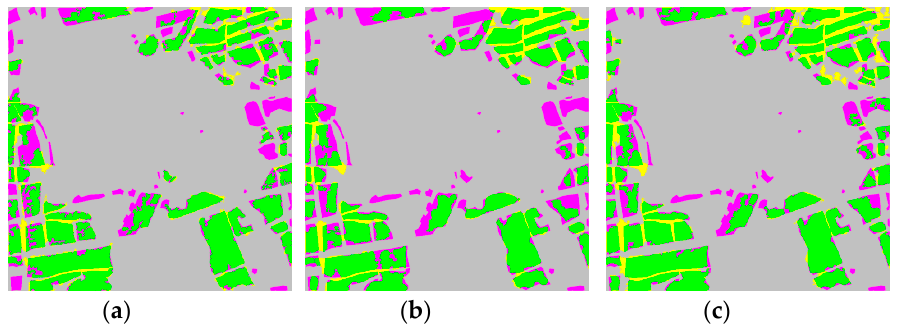
Figure 8. Backscattering characteristics of GF3.